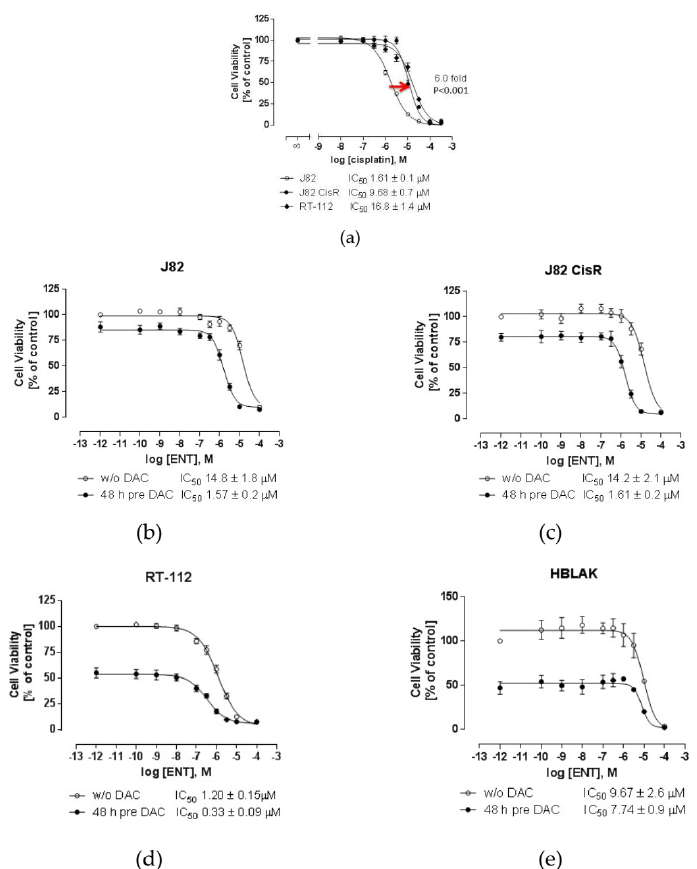
Figure 1. Generation of the cisplatin-resistant cell line J82CisR and combination treatment with DAC and ENT. ( a ) Thirty-four cycles of weekly exposure of J82 with cisplatin for 6 hours resulted in 6-fold ( p < 0.001) increase in IC 50 [inhibitory concentration 50%] of cisplatin in J82CisR as indicated by the red arrow. IC 50 of cisplatin in J82: 1.61 µ M; IC 50 of cisplatin in J82CisR: 9.68 µ M. Data shown are mean ± SEM, n = 3. ( b ) Forty-eight hours pre-incubation with DAC (1 µ M) significantly enhanced the cytotoxicity of ENT in J82 cell line by decreasing IC 50 from 14.8 µ M to 1.57 µ M with a shift factor of 9.4. ( c ) Pre-incubation with DAC (1 µ M) decreased IC 50 of ENT from 14.2 µ M to 1.61 µ M in J82CisR. ( d ) Pre-incubation with DAC (0.1 µ M) increased the cytotoxic e ff ect of ENT in RT-112 as shown by a shift factor of 3.6. ( e ) Pre-incubation of DAC (1 µ M) did not significantly increase the cytotoxic e ff ect of ENT in the normal human bladder cell line HBLAK. “% of control” on the y-axis means: % of untreated